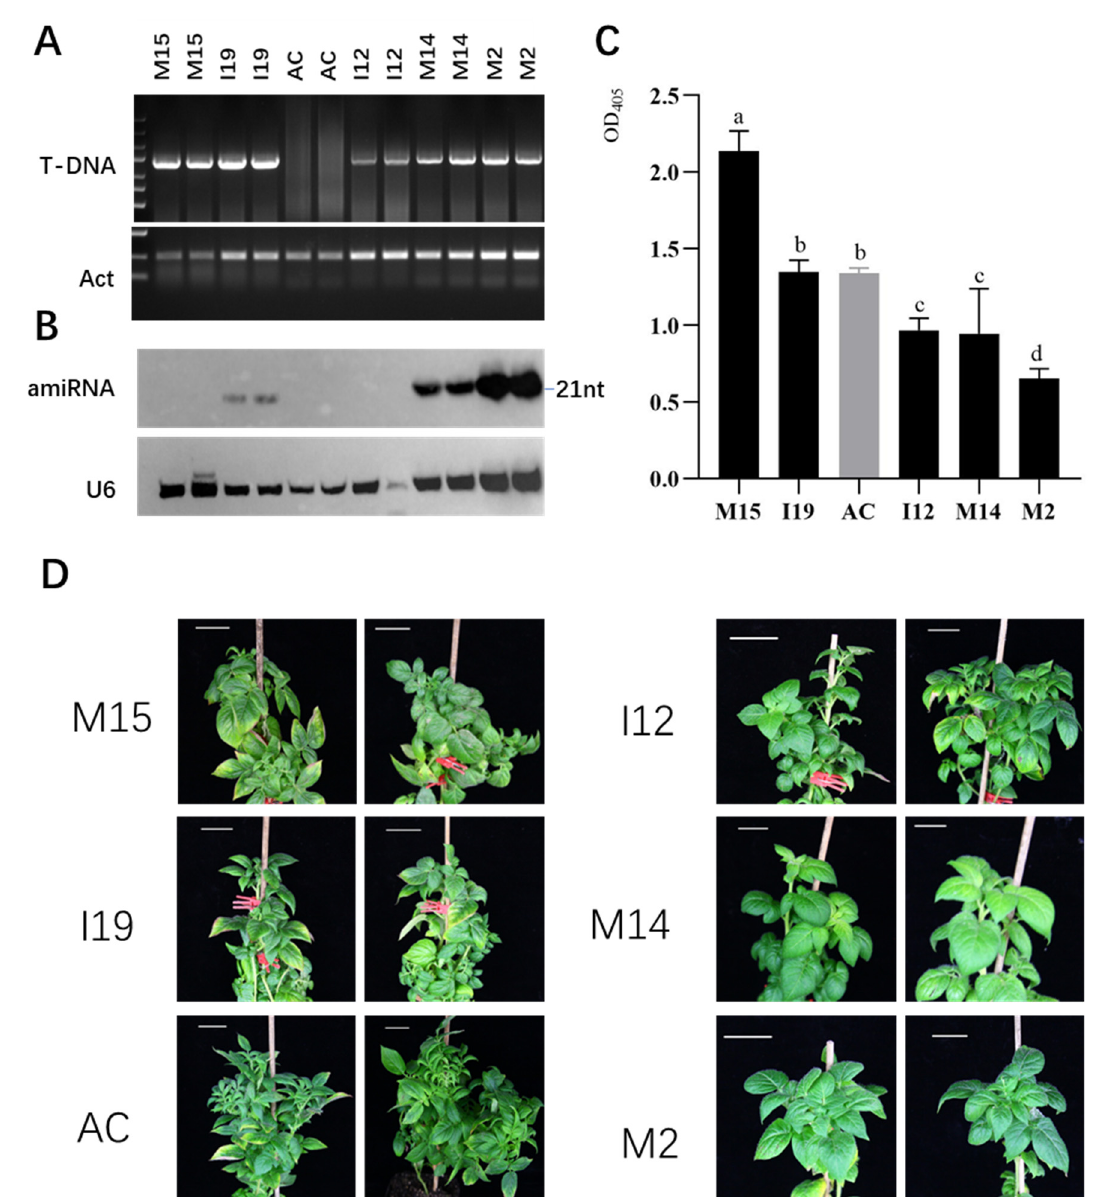
Figure 3. Characterization of pAMIR–PLRV transgenic plants. ( A ) PCR detection of pAMIR–PLRV T-DNA insertion in transgenic and wild-type potato lines. Transgenic line IDs (M15, I19, I12, M14 and M2) and wild-type control lines AC142 (AC) are indicated at the top of each lane. PCR products amplified using pAMIR–PLRV T-DNA and endogenous control actin DNA (Act) are indicated to the left of each gel. ( B ) Northern blot detection of mature miRNAs expressed from PLRV–AMIR. Mixed probes complementary to all four amiRNAs were used. The blot of U6 RNA served as an equal loading control. amiRNA size is indicated to the right of the blot. ( C ) ELISA assay for samples from top young leaves of infected plants using PLRV CP-specific antibody. The difference among the ELISA values of different samples was analyzed by Duncan’s new multiple range test and was indicated by letters above each column. ( D ) Disease symptoms in wild-type (AC142) and transgenic potato lines (M15, I12, I19, M14, M2) after PLRV infection.